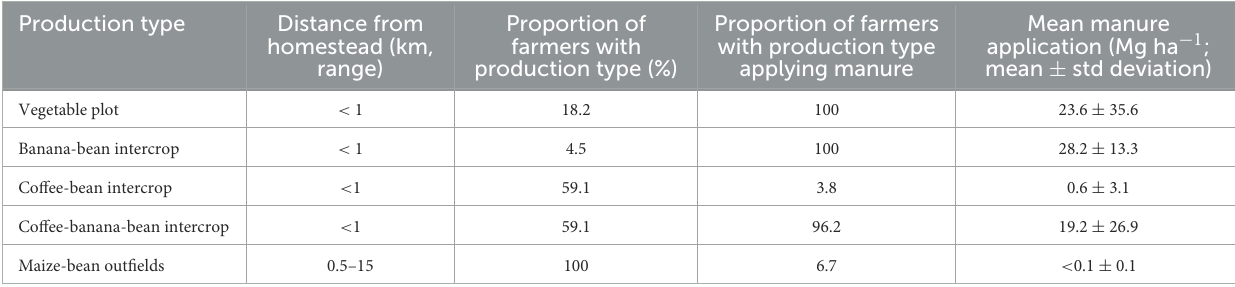
TABLE 3 Distance from homes, proportion of farmers applying manure, and mean manure application rates of different crop production types of 45 farms in Narumu Ward, Kilimanjaro region, Tanzania.